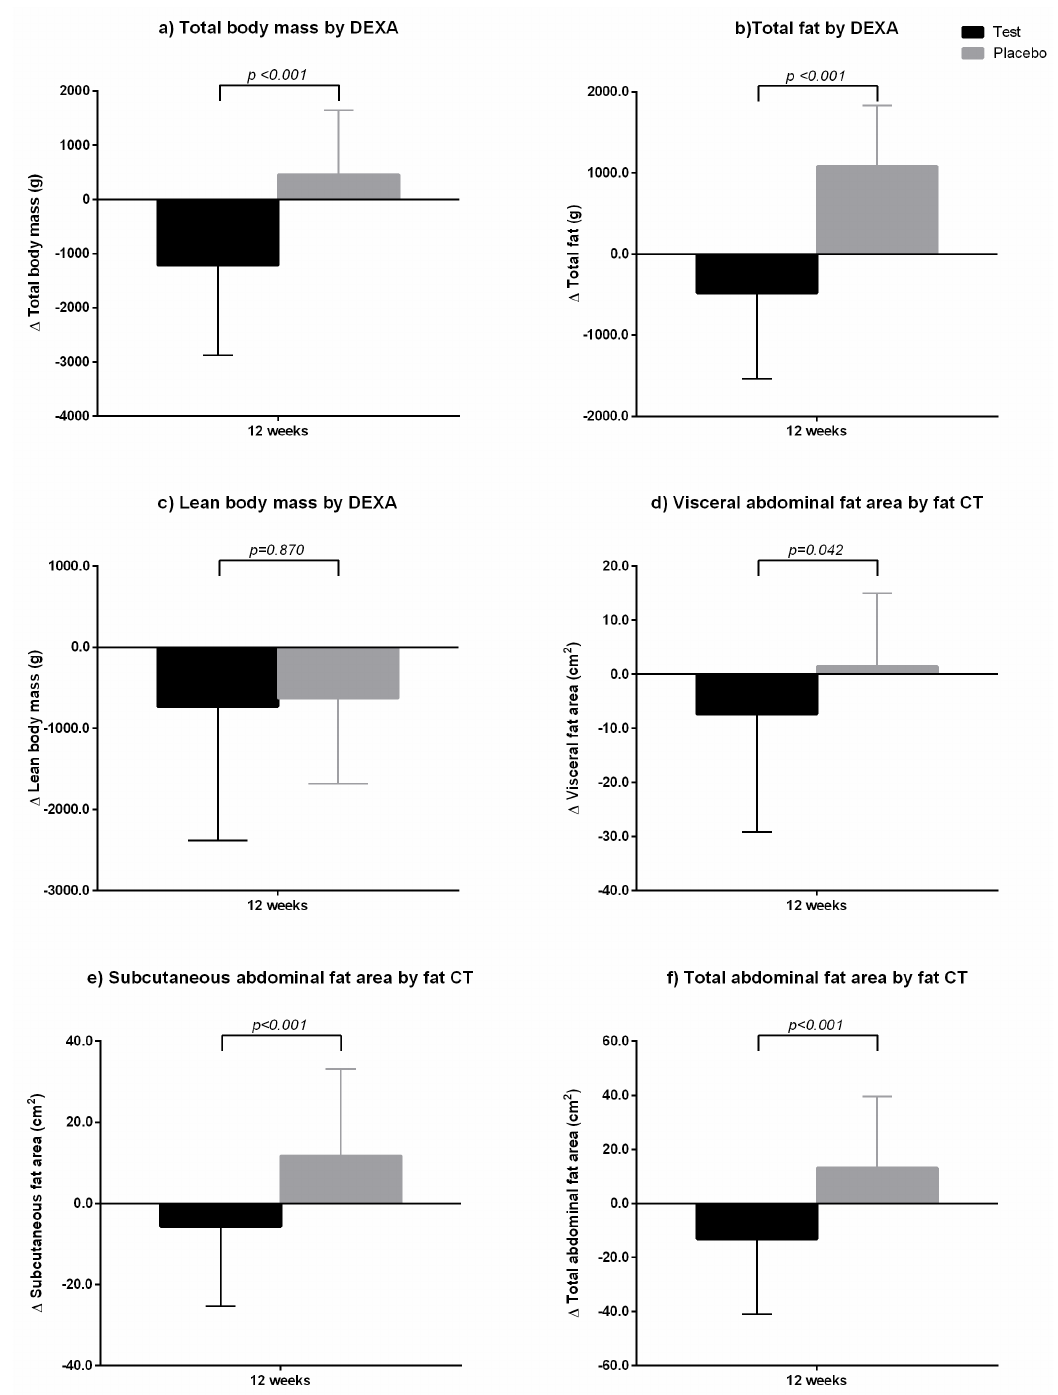
Figure 4. Changes in body composition from baseline between the two groups at 12 weeks. The test group was administered Gelidium elegans extract 1000 mg/day for 12 weeks, and the placebo group was administered placebo in a similar manner. ( a ) Total body mass by DEXA; ( b ) total fat mass by DEXA; ( c ) lean body mass by DEXA; ( d ) visceral abdominal fat area by fat computed tomography (CT); ( e ) subcutaneous abdominal fat area by fat CT; and ( f ) total abdominal fat area by fat CT. p -values were calculated using an ANCOVA test adjusted for baseline value, calorie intake, and physical activity.